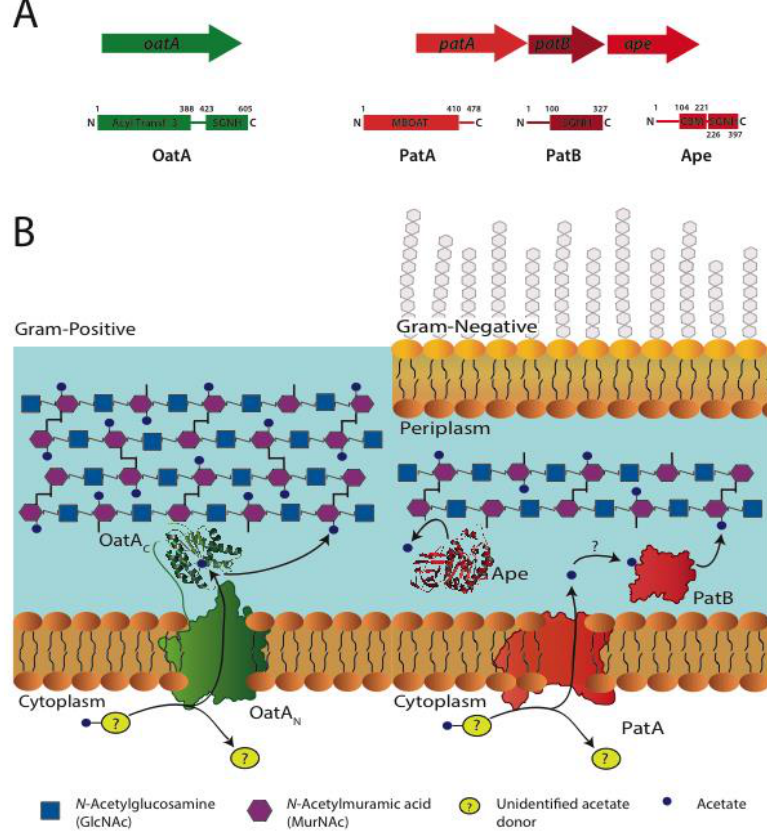
Figure 4. Gene organization and proposed models for PG O-acetylation. ( A ) Organization of genes encoding enzymes involved in the O-acetylation and de-O-acetylation of PG, and the domain organization of respective protein products. ( B ) Current models of O-acetylation systems for Gram-positive and Gram-negative bacteria. In both cases, a membrane spanning O -acetyltransferase (OatA N / PatA) acquires an acetyl group from an unidentified cytoplasmic source for its translocation to the external leaflet of the cytoplasmic membrane. The acetyl group is received by the dedicated PG O -acetyltransferase (OatA C / PatB) which modifies the C-6 OH of MurNAc. In Gram-negative bacteria, an esterase, Ape, is produced to remove the modification allowing for remodeling of the sacculus. Figure adapted from [5].